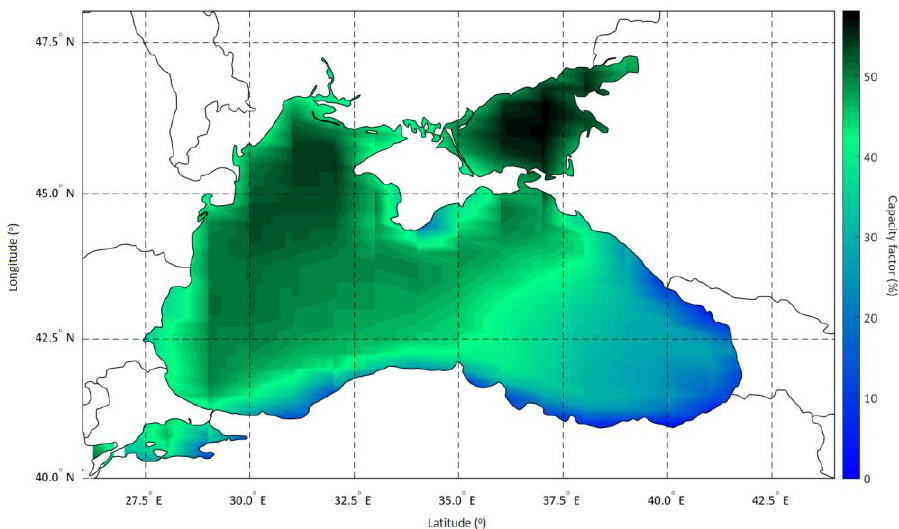
Figure 9. Airborne 500 kW — capacity factor (in %) computed for the total time interval based on the U200 wind conditions.